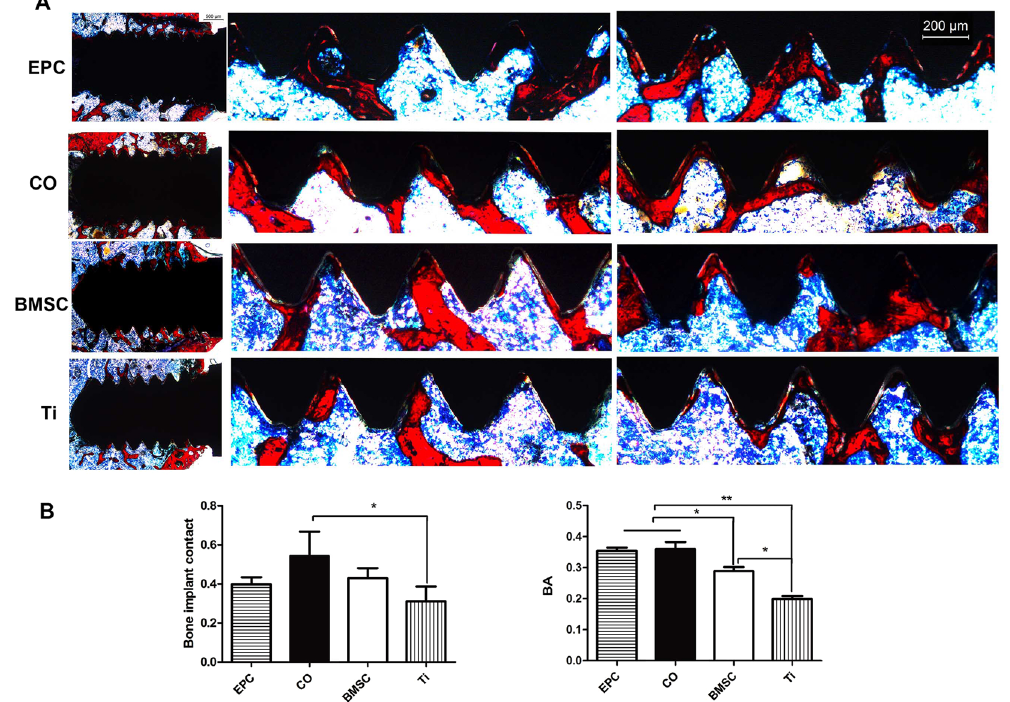
Figure 7. Histological analysis of newly formed bone around implants. ( A ) The first column shows the overall image of implants of each group (Original magnification x25) and the second and third column show bone formation around the upper and lower screws (Original magnification x50). ( B ) The graphs show the BIC and BA per x50 field in histological sections. ( * p < 0.05, ** p < 0.01).